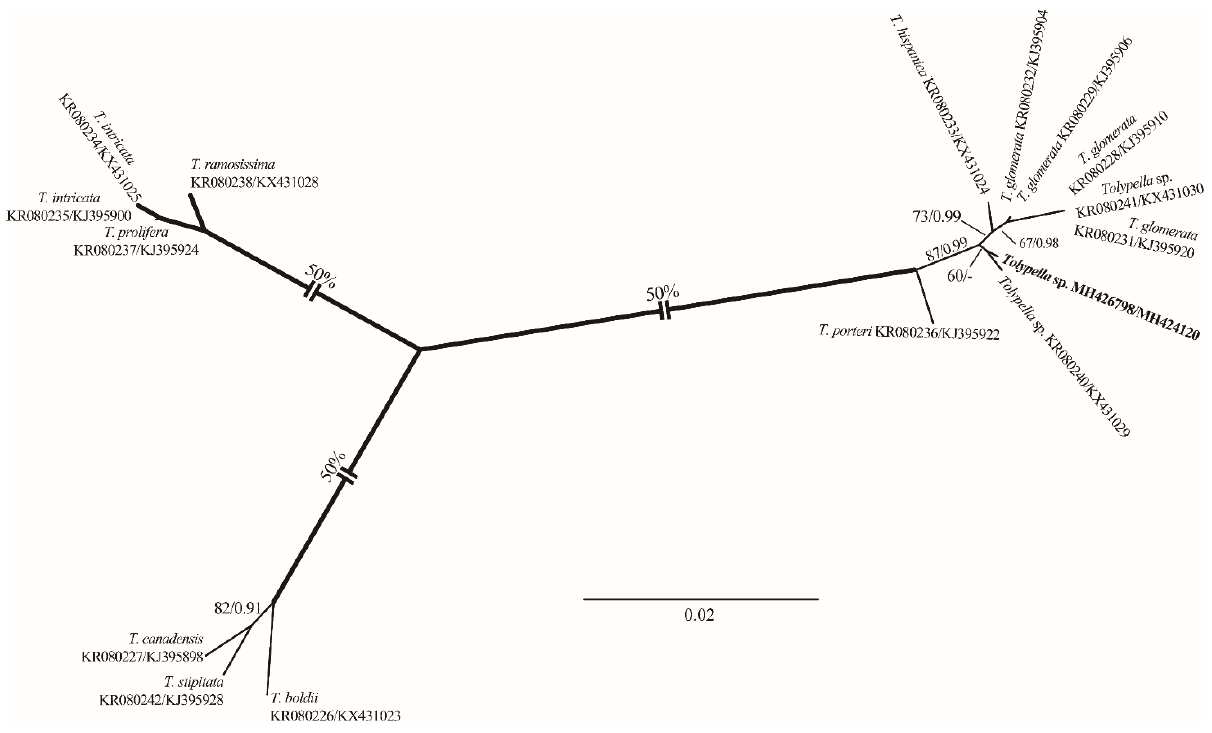
Figure 2 . Phylogeny of Tolypella based on 16 concatenated rbc L and ITS1 sequences. ML tree was inferred in PAUP with TrN+G nucleotide substitution model. See the legend of Figure 1 for details. Long internal branches were graphically reduced 50%.